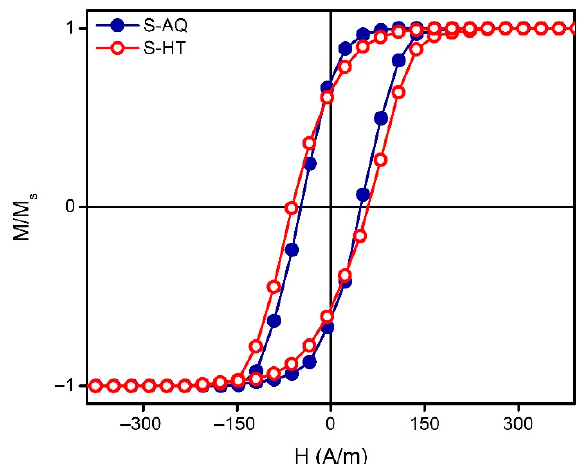
Figure 3. Magnetic hysteresis loops of the as-quenched amorphous ribbons (S-AQ) and the amorphous ribbons after the heat treatment (S-HT). Measurements were made at the temperature of 295 K.